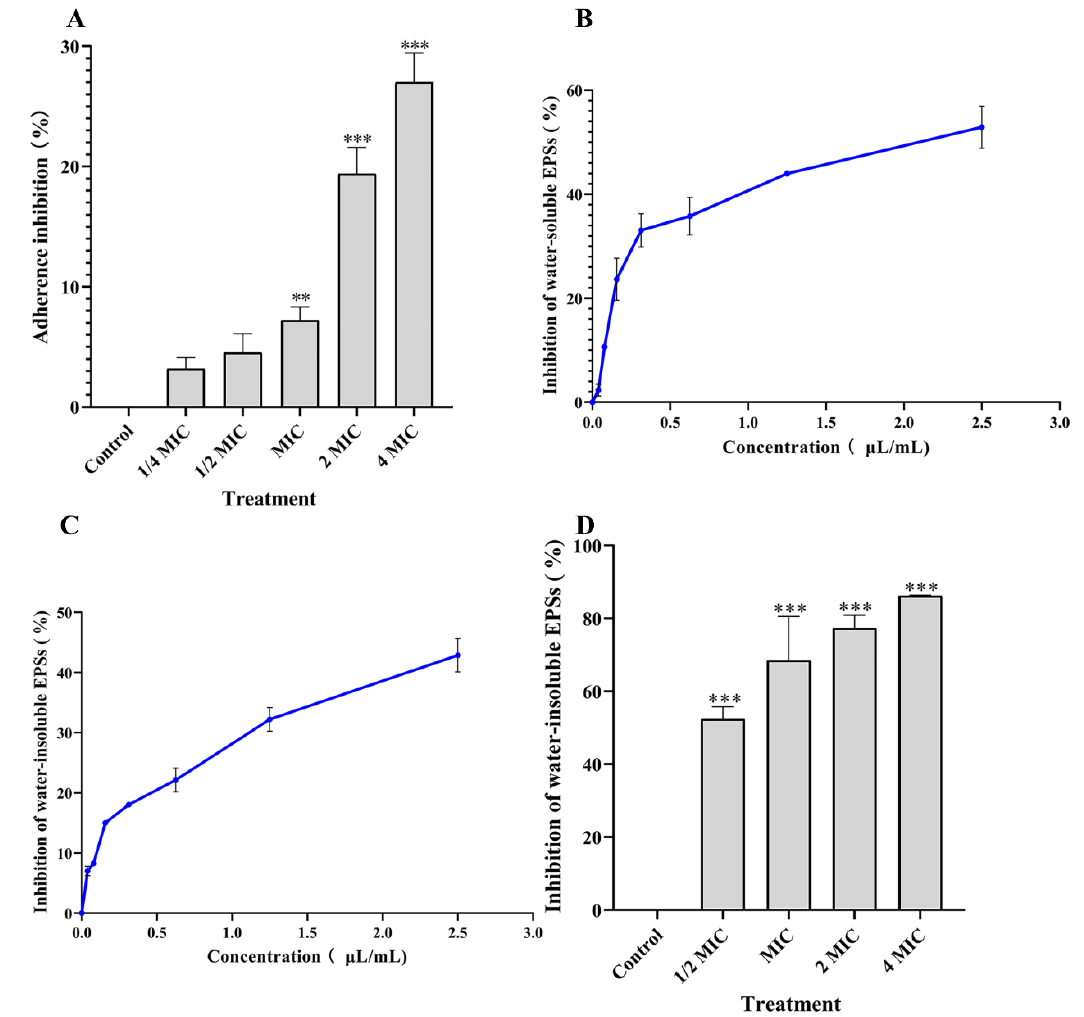
Figure 4. Effects of PEO on cell adhesion, polysaccharides (EPSs) and glucosyltransferases (GTFs). ( A ) PEO decreases bacterial adherence in a concentration-dependent way. ( B ) PEO inhibits water- soluble polysaccharides. ( C ) PEO inhibits water-insoluble polysaccharides. ( D ) PEO depresses the activity of GTFs, and the changes in the water-insoluble polysaccharide content produced were used to indicate PEO’s effect on GTFs (** p < 0.01, *** p <0.001). 1/4MIC, 0.15625 µ L/mL; 1/2MIC, 0.3125 μL/mL; MIC, 0.625 μL/mL; 2MIC, 1.25 μL/mL; 4MIC, 2.5 μL/mL.